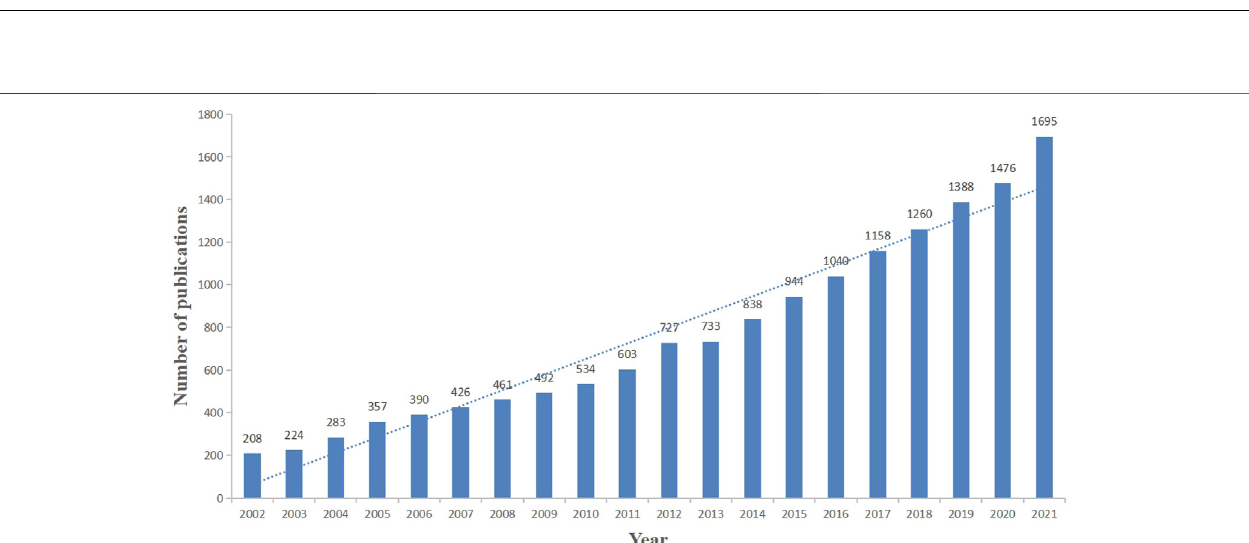
FIGURE 2 | Chronological trend of publications about the treatment of liver fi brosis.jpg.